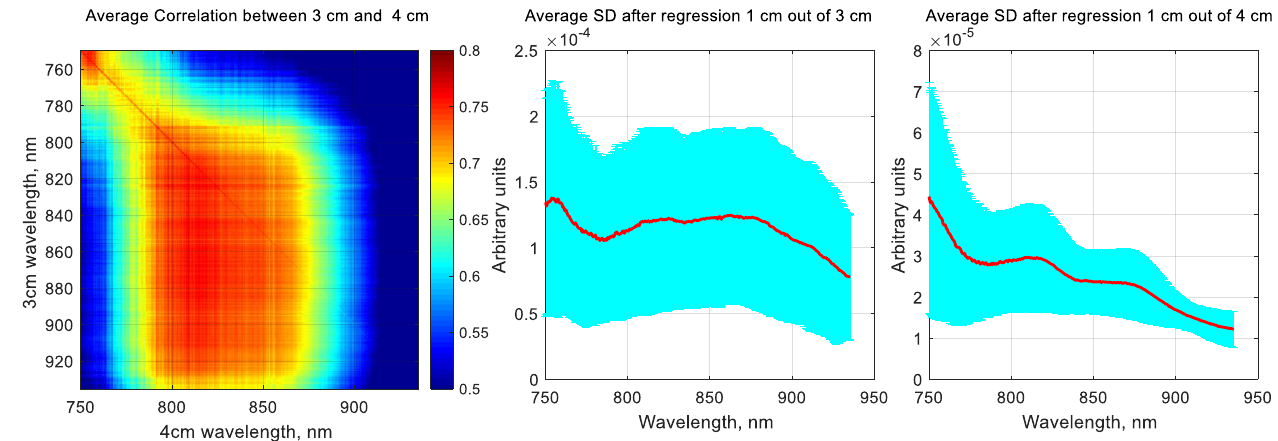
Figure 6. Cross-subject average correlation and standard deviation spectra of signals from the 3 cm and 4 cm channels after regressing out changes measured at the 1 cm channel.